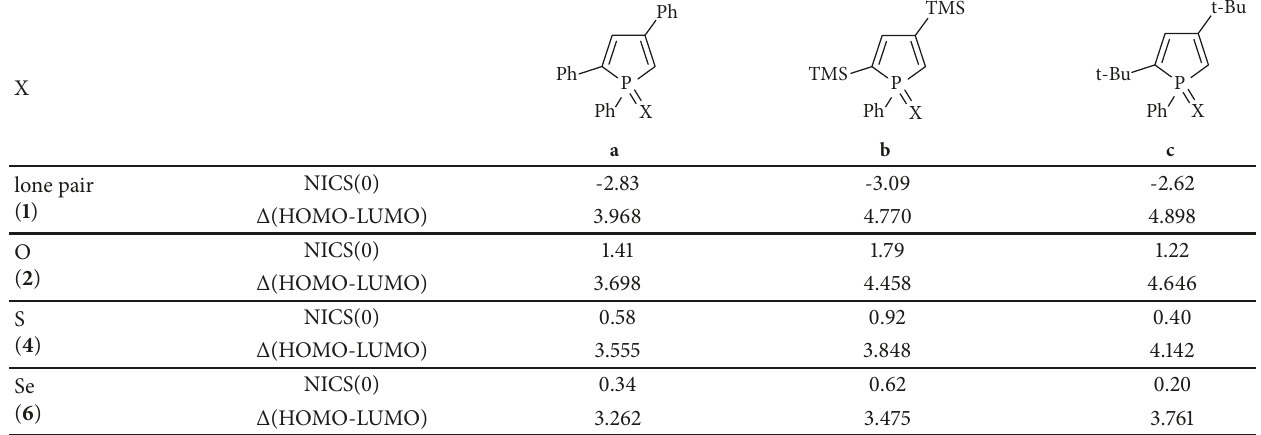
Table 6: Comparison of NICS(0) (ppm) and HOMO-LUMO gap (eV) for three disubstituted phospholes and their